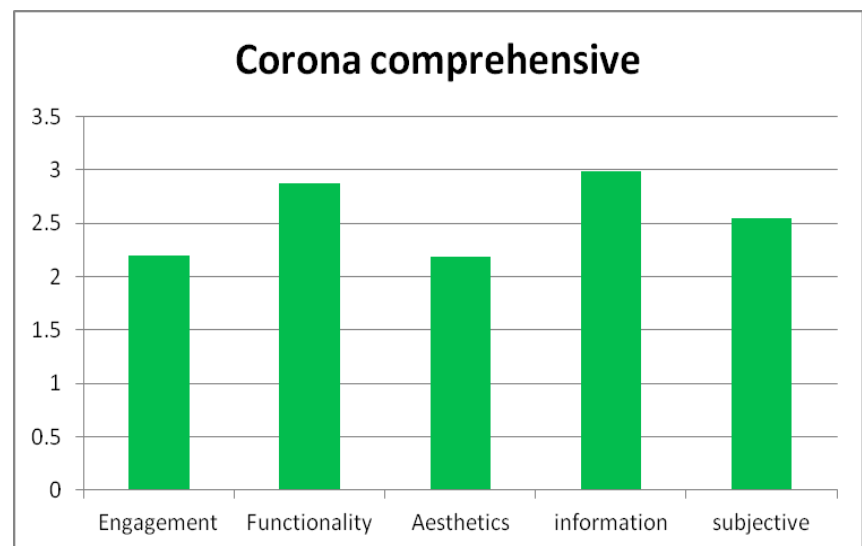
Fig 11. The evaluation of indicators in Corona comprehensive according to MARS